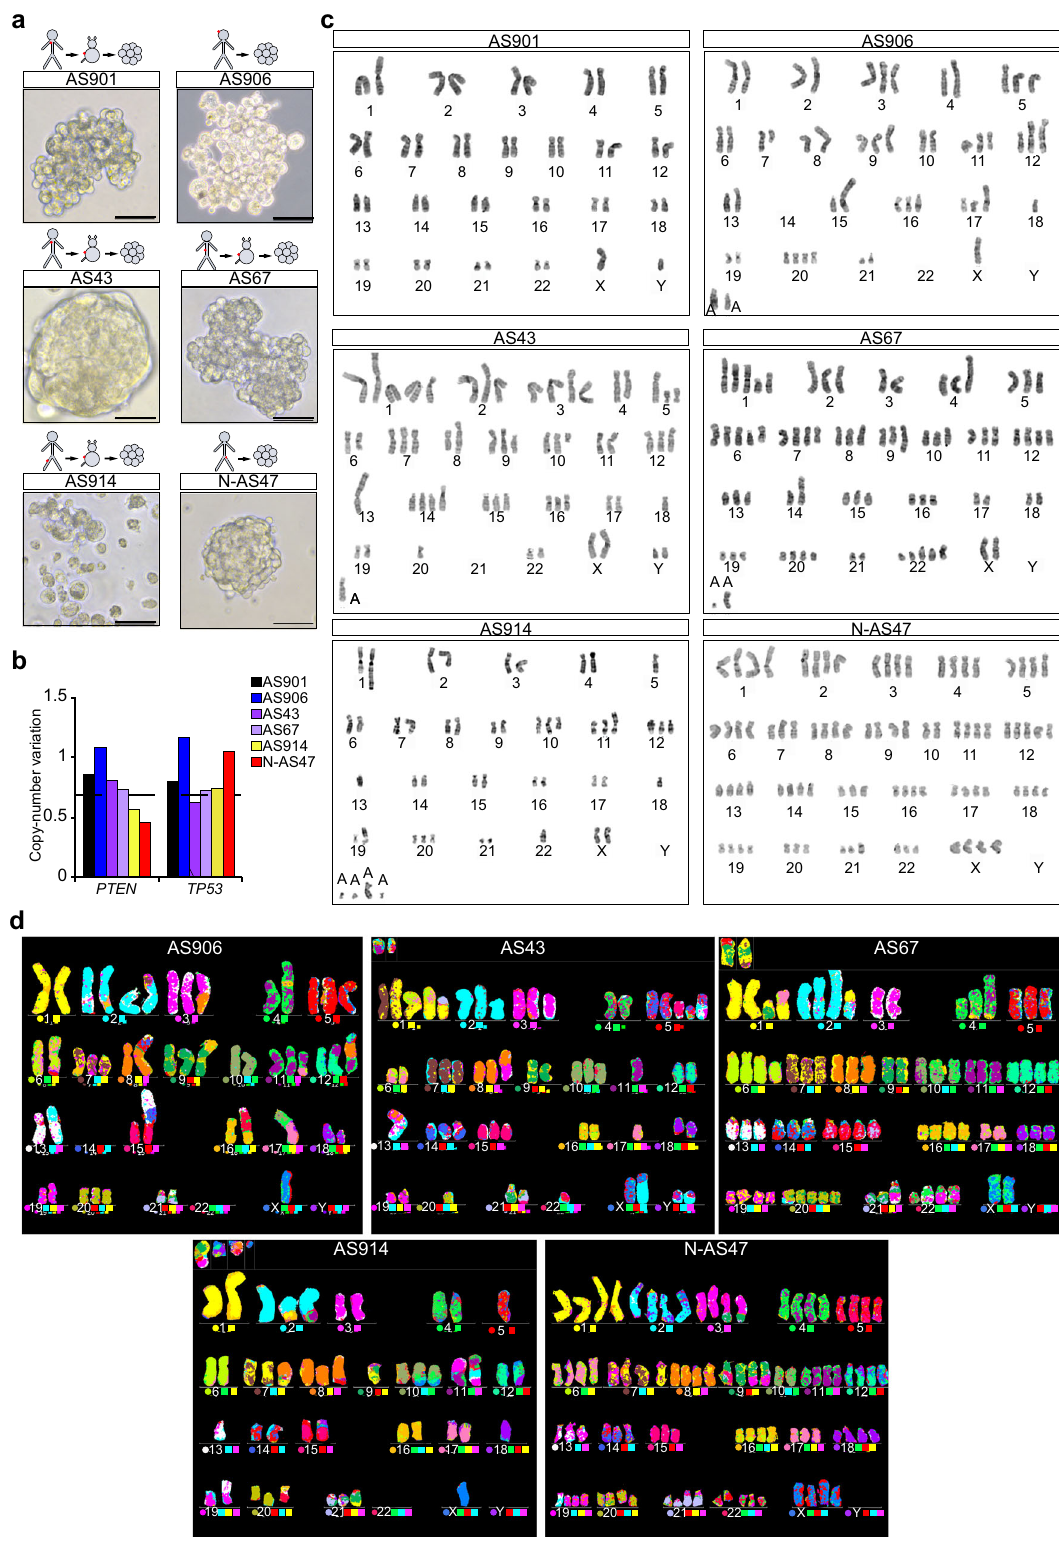
Fig. 1 Agnospheres can be isolated from cancers of unknown primary and display the genetic makeup of the original tumors. a Morphological appearance of agnospheres derived from CUP tissues propagated in mice or directly from human tissues. b PTEN and TP53 copy-number variations measured by qPCR in gDNA from agnospheres. Value = 1 indicates biallelic content; values < 0.7 (dotted line) indicate allelic loss, ( n = 2 independent experiments with similar results were obtained). c Representative G-banded karyotypes of agnospheres. A: marker chromosome. d Representative images of spectral karyotypic analysis (M-FISH) on metaphases of: AS906 ( n = 16) showing a near-diploid karyotype; AS43 ( n = 9), containing two major clones with different karyotypes (near-diploid and hypotriploid); AS67 ( n = 20) with hypertriploid modal karyotype; AS914 ( n = 20) showing a near-diploid modal karyotype; and N-AS47 ( n = 13), including three major clones (near-diploid, near-triploid, and near-tetraploid). NATURE COMMUNICATIONS| (2021) 12:2498